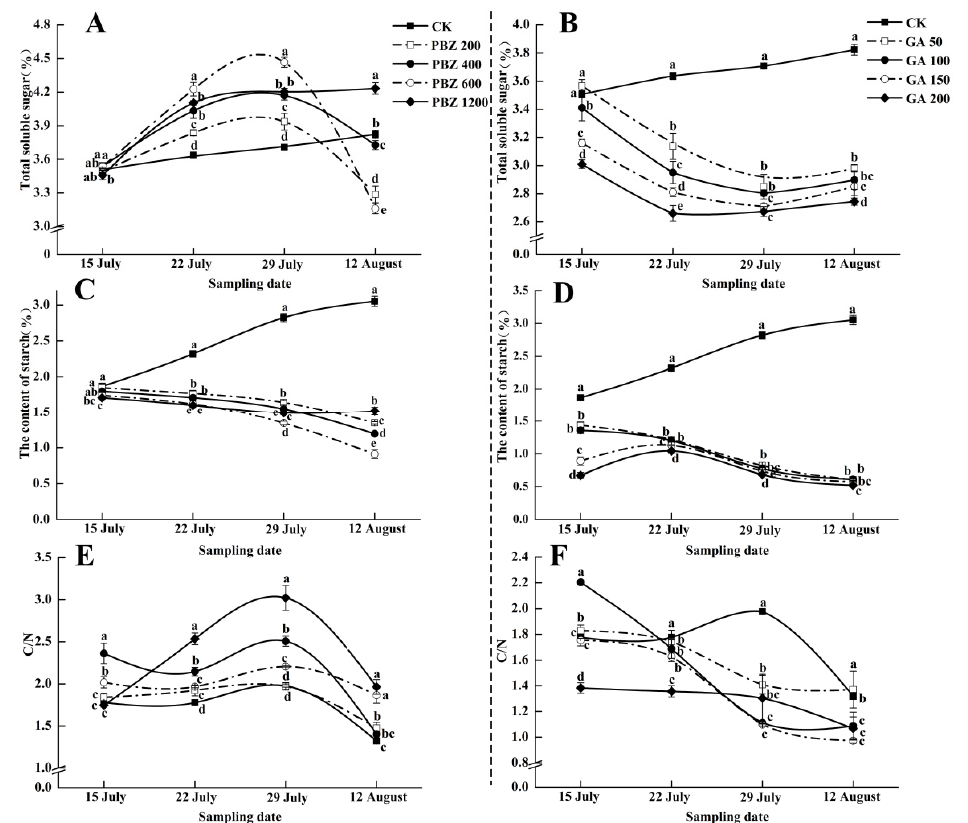
Figure 5. Effects of hormone regulation on total soluble sugar ( A , B ), and the starch contents ( C , D ), and C/N ratio ( E , F ) of lemon leaves. The left-hand plants were treated with paclobutrazol, and the right-hand plants were treated with gibberellin. Different letters (a, b, c and d) denote significant differences based on a p value < 0.05.